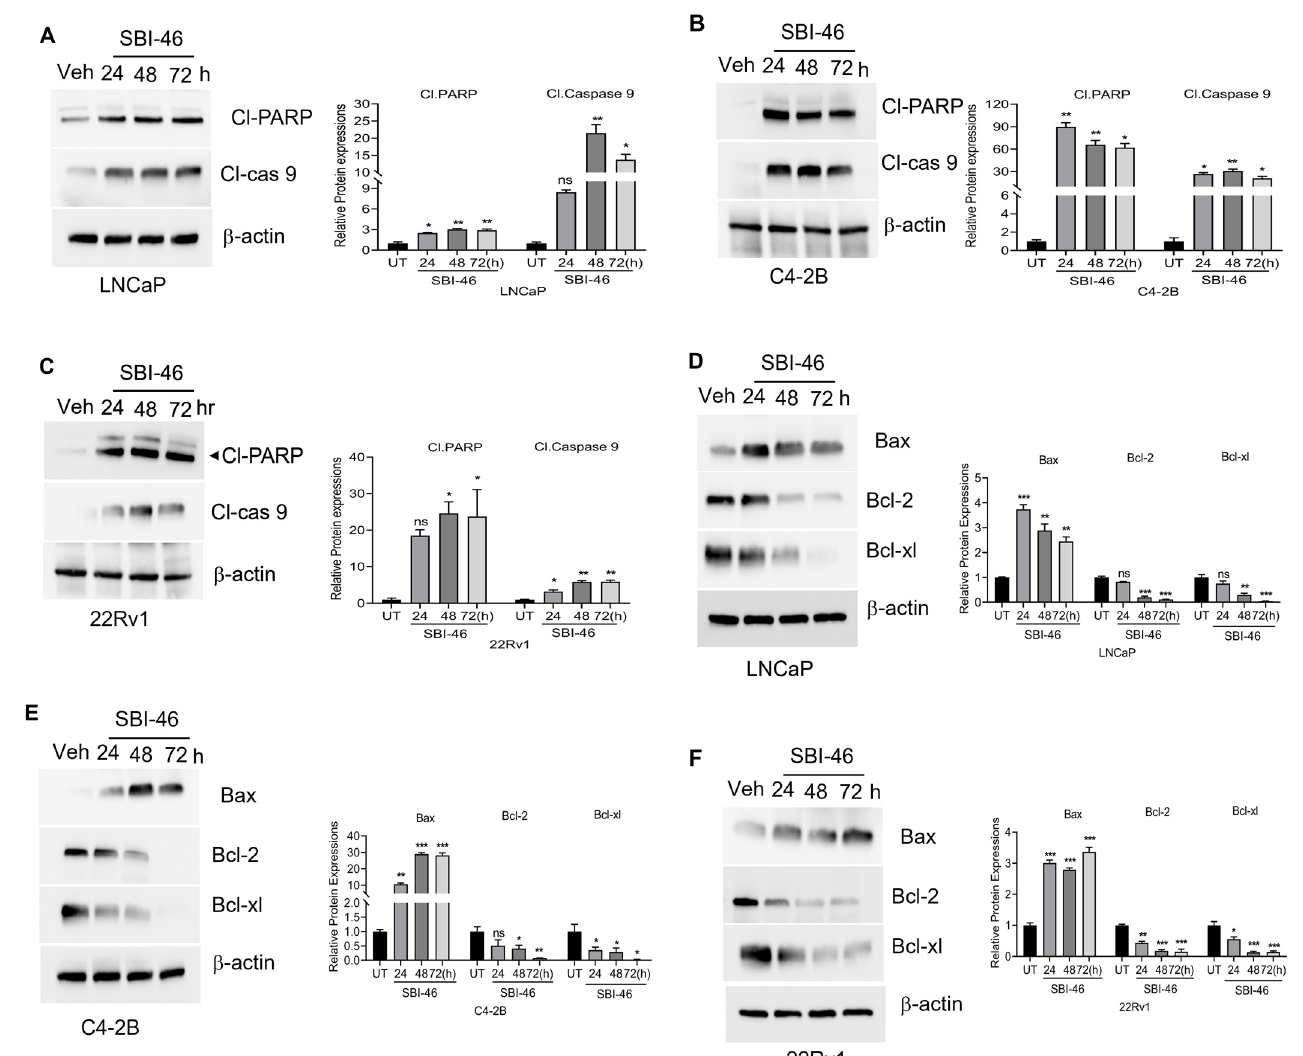
Figure 4. SBI-46 induces apoptosis in PCa cells. ( A – F ), Cell lysates from SBI-46-treated PCa cells were analyzed by Western blotting with the indicated antibodies. Densitometry analysis was performed with ImageJ software for the immunoblots. The p -values corresponding to various symbols used are: (ns), not significant ( p > 0.05); * p < 0.05; ** p < 0.01 and *** p < 0.001. The uncropped blots are shown in the Supplemental Materials.